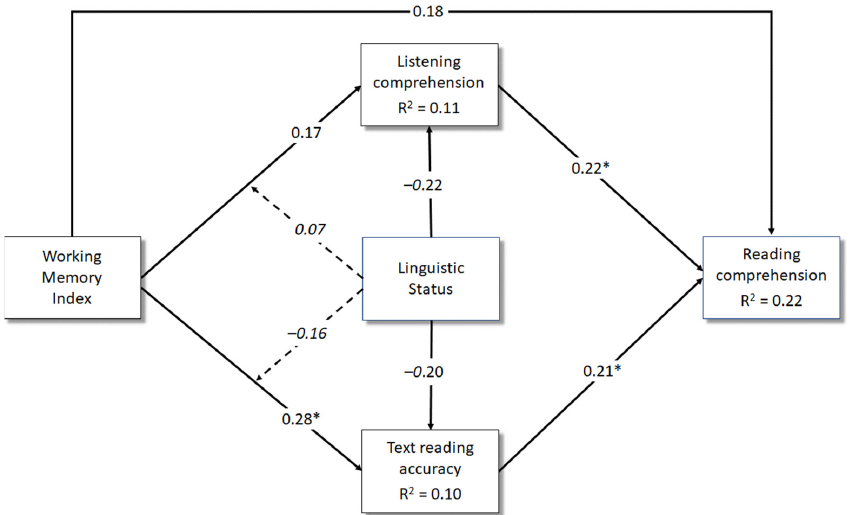
Figure 1. Model 1: A multiple regression analysis including the working memory index (predictor), listening comprehension and reading accuracy (mediators), linguistic status (moderator) and reading comprehension (outcome). Notes . * p < 0.05. Dashed lines indicate the moderating effect of linguistic status. Parents’ years of education were not represented to avoid cluttering the figure. Standardised betas for this covariate were 0.19 ( p = 0.07) for listening comprehension, 0.12 ( p = 0.21) for text reading accuracy and 0.10 ( p = 0.31) for reading comprehension.